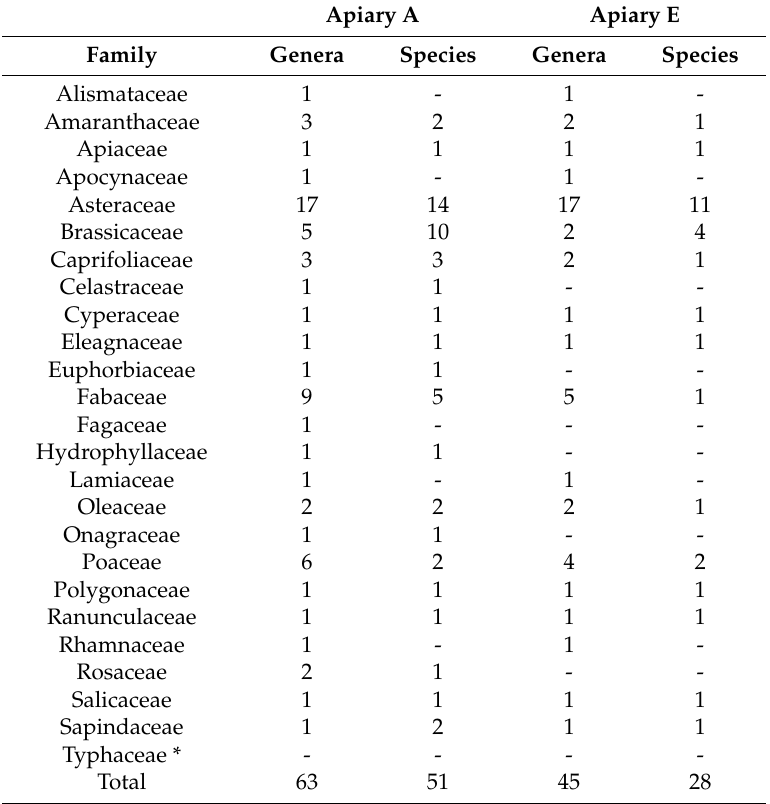
Table 1. Plant families, and number of genera and species contained therein, ascribed in honey bee forager-collected pollen from apiaries A and E on 19 sample dates from May–September, 2014. Apiary